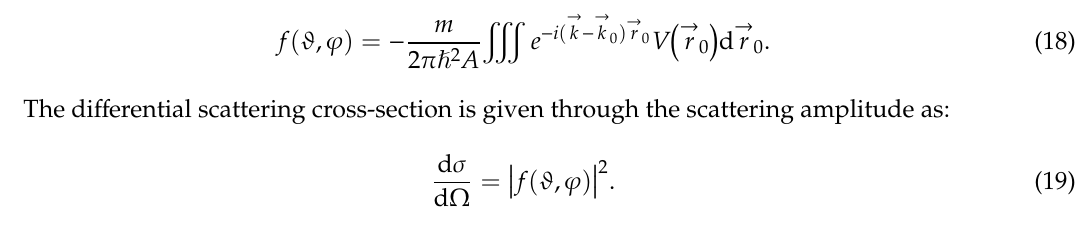
Figure 1. Schematic of the electron scattering event and illustration of the symbols used. are the wave vectors of the incident plane wave and the scattered wave, respectively, and ϑ is the scattering